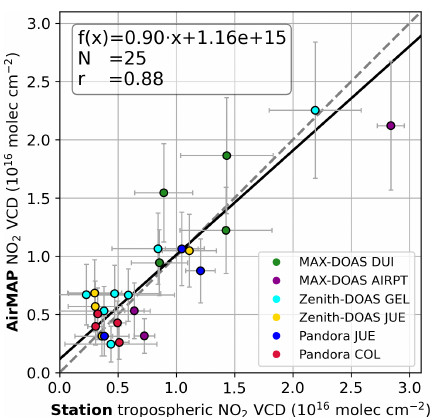
Figure 6. Scatter plot of AirMAP data against the stationary ground-based NO 2 VCDs averaged over a time interval of 20min closest to the AirMAP overpass data, which are averaged over a 500m × 500m area around the station site. Each point is colored according to its ground-based instrument type and location. Error bars represent the error in the tropospheric NO 2 VCD retrieval, av- eraged within the 500m × 500m grid boxes and 20min time inter- vals. The 1:1 line is indicated by the dashed grey line. The solid black line represents the orthogonal distance